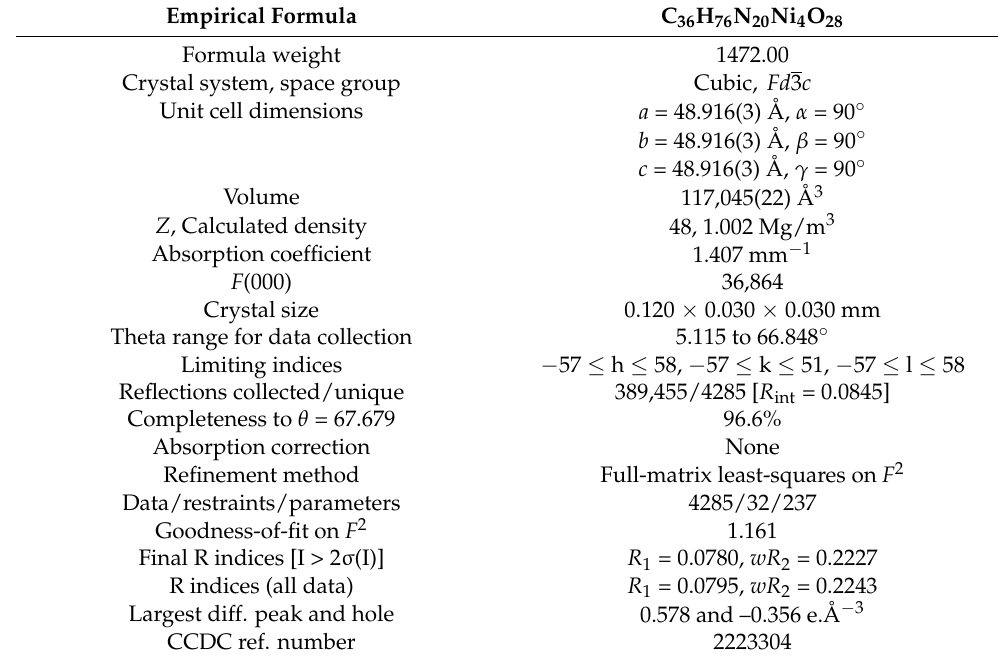
Table 1. Crystal data and structure refinement for [Ni( µ 2 -N7,O6-acv-H)(MeO)(H 2 O)] 4 · 8H 2 O ( 1